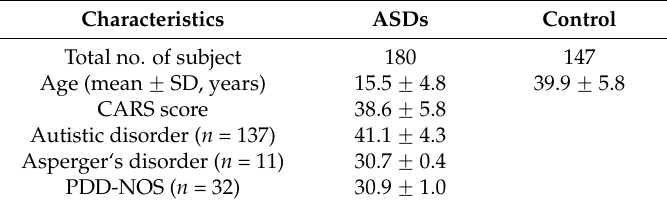
Table 3. Clinical characteristics of ASD patients and control